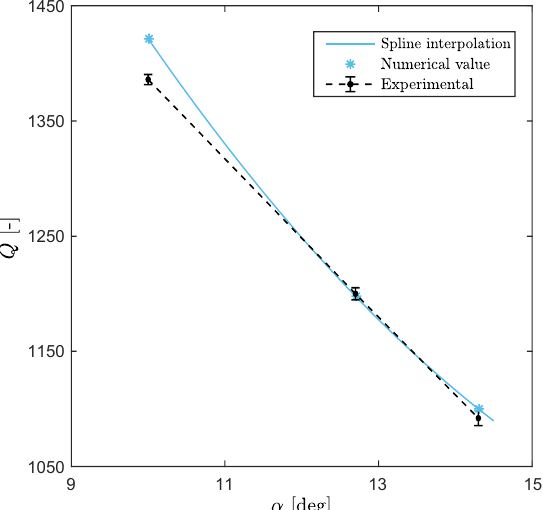
Figure 13. Comparison between experimental and numerical quality factors for Micromirror 2. The dependence of Q with respect to maximum amplitude α is almost